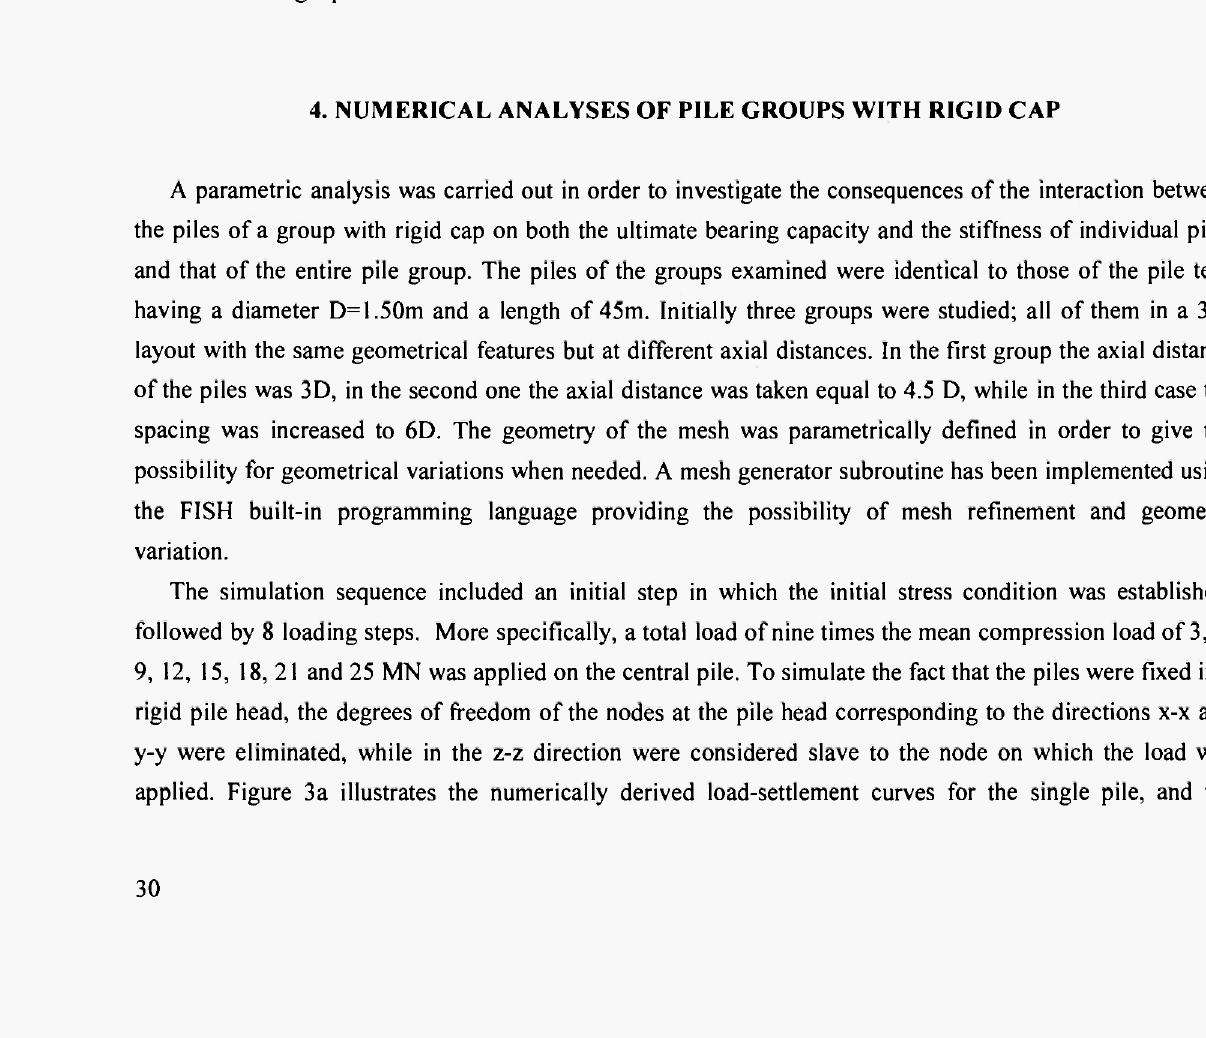
Fig. 2: Comparison of pile test load-settlement curve with the numerically established curves for pile test and single